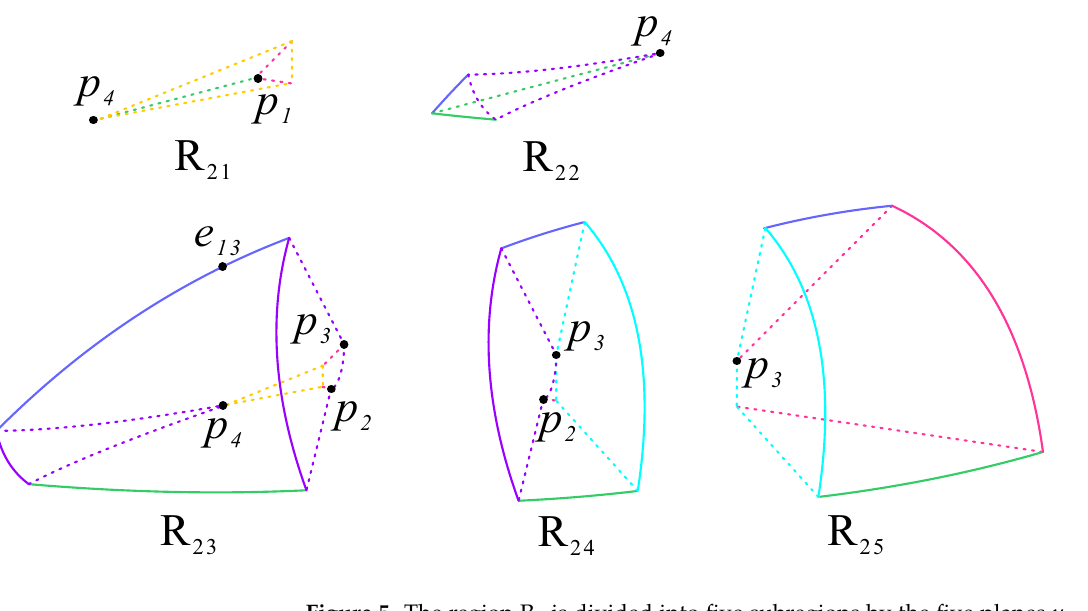
Figure 5. The region R 2 is divided into five subregions by the five planes y = 0, z = 0, Ω ( m ) = 0, b 2 = 0, and b 3 = 0, and one surface b 1 = 0. Table 3. Dynamic behavior of the trajectories in the five